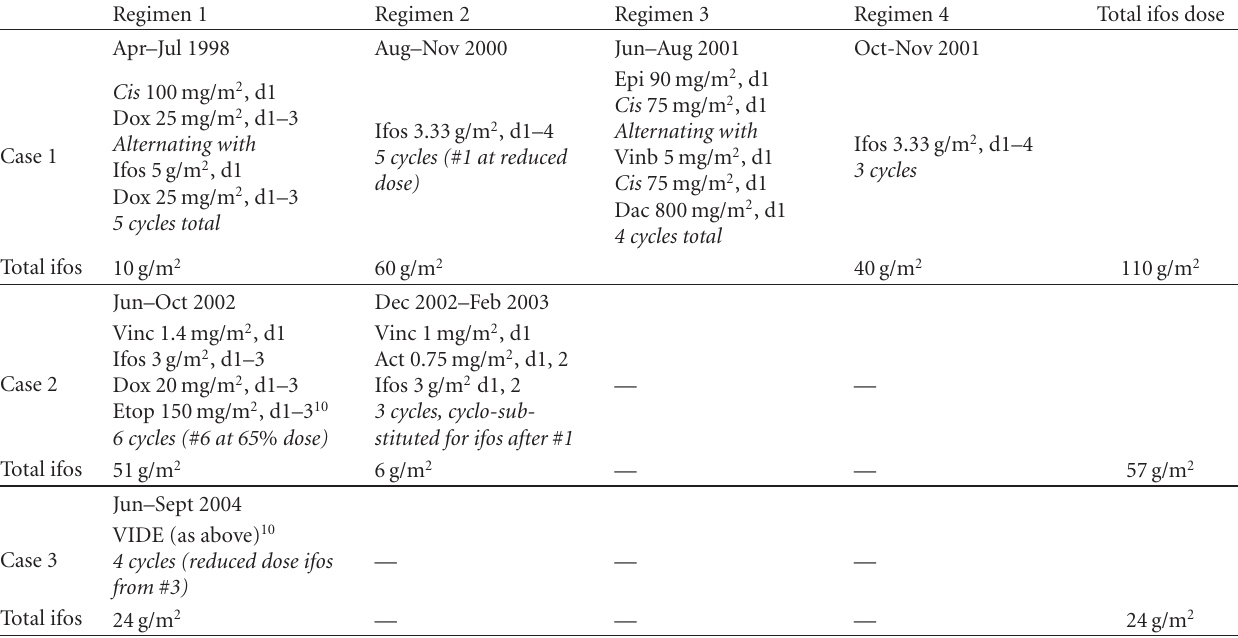
Table 1: Chemotherapeutic regimens used in cases. Cis : cis platin, dox: doxorubicin, ifos: ifosfamide, epi: epirubicin, vinb: vinblstine, dac: dacarbazine, vinc: vincristine, etop: etoposide, act: actinomycin D, cyclo: cyclophosphamide. Note that cis platin was administered with pre- and posthydration and ifosfamide was demonstrated as an infusion with concurrent mesna in all